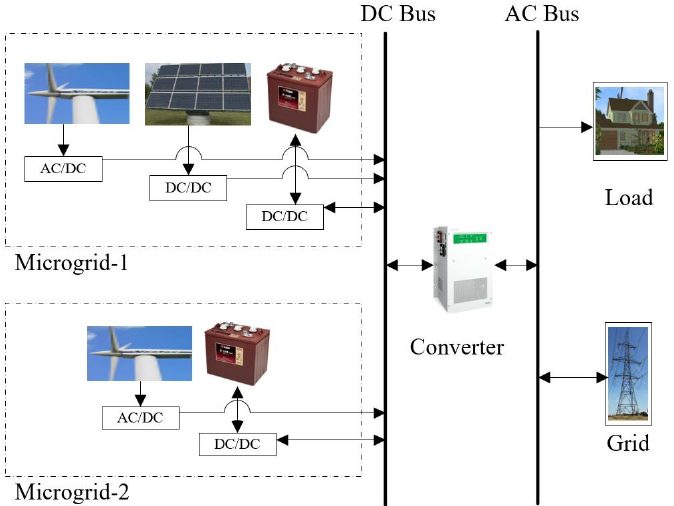
Figure 3. Block diagram of a networked microgrid.